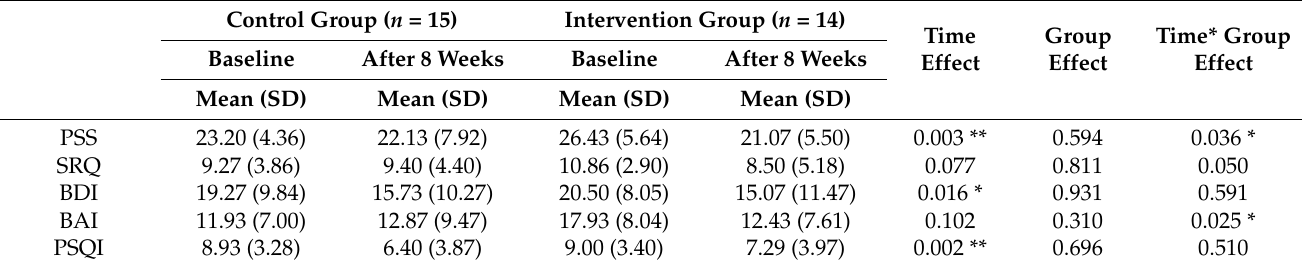
Table 2. Experiment 1: Comparison between intervention and control groups at baseline and after 8